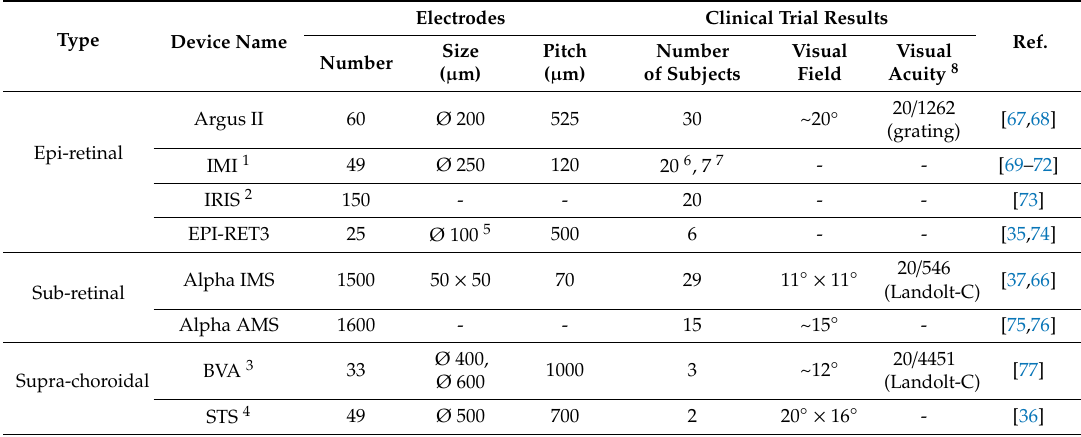
Table 1. A summary of three approaches to current retinal prostheses applied in clinical